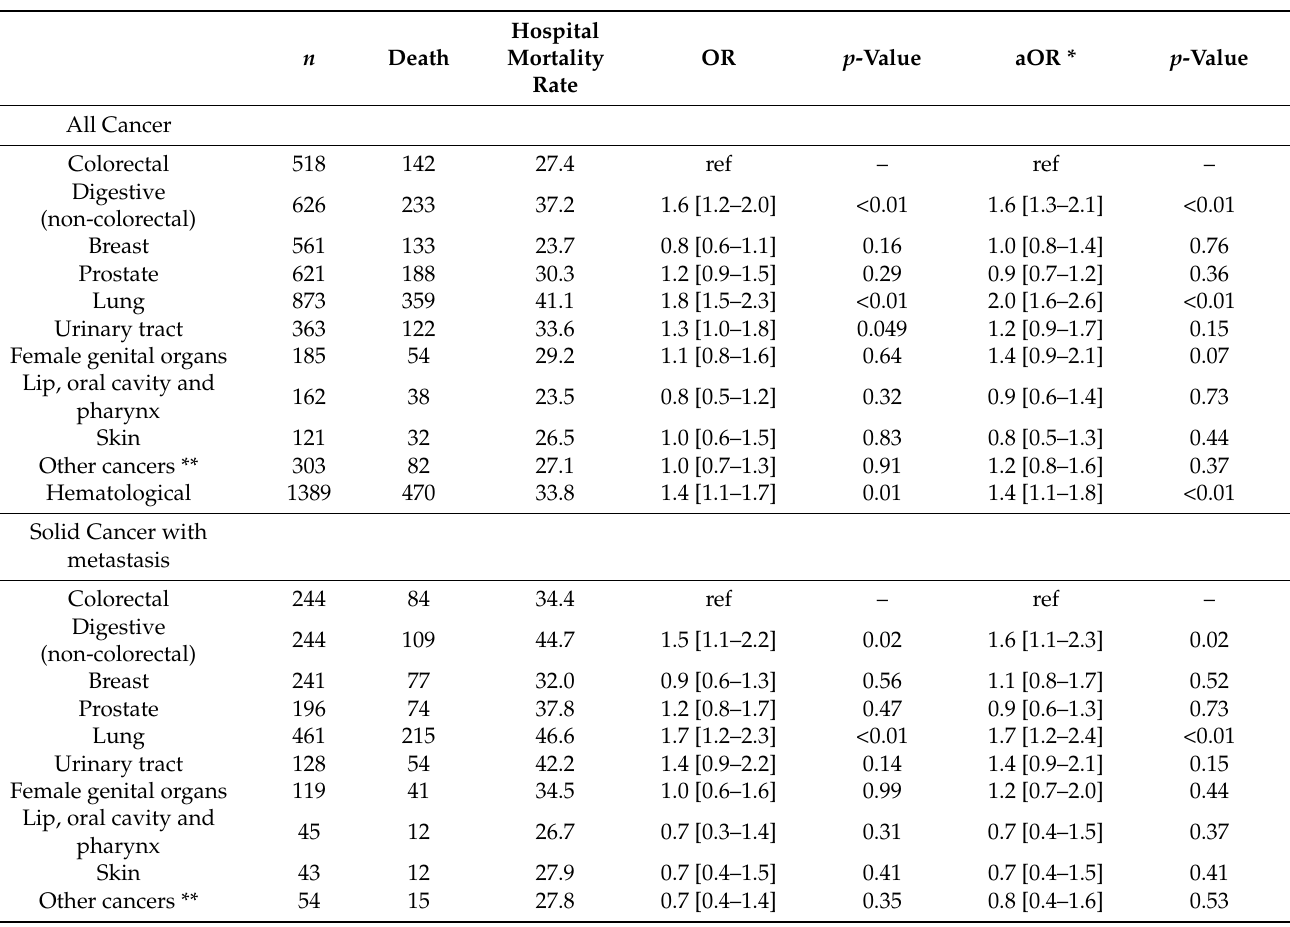
Table 5. Logistic regression to study the risk of hospital death among cancer patients hospitalized in France for COVID-19 (from 1 March 2020 to 30 April 2020), using colorectal cancers as the reference group.